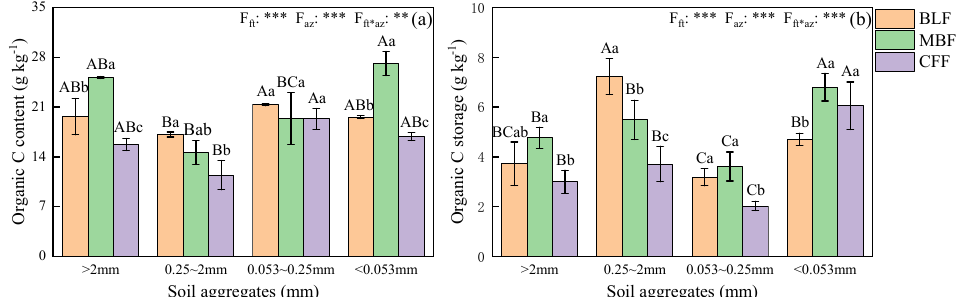
Figure 4. The comparison of soil aggregate carbon content ( a ) and storage ( b ) in different forest types of the same fraction and different fractions of the same forest type. Bars with different letters are significantly different ( p < 0.05). Small letters indicate difference of soil aggregate organic C content in three forest types with the same fraction. Large letters indicate difference of soil aggregate organic C content in different fractions in same forest types. F ft represents forest type, F af represents aggregate fraction, NS indicates no significant difference. *: p < 0.05, **: p < 0.01, ***: p < 0.001. The same below.